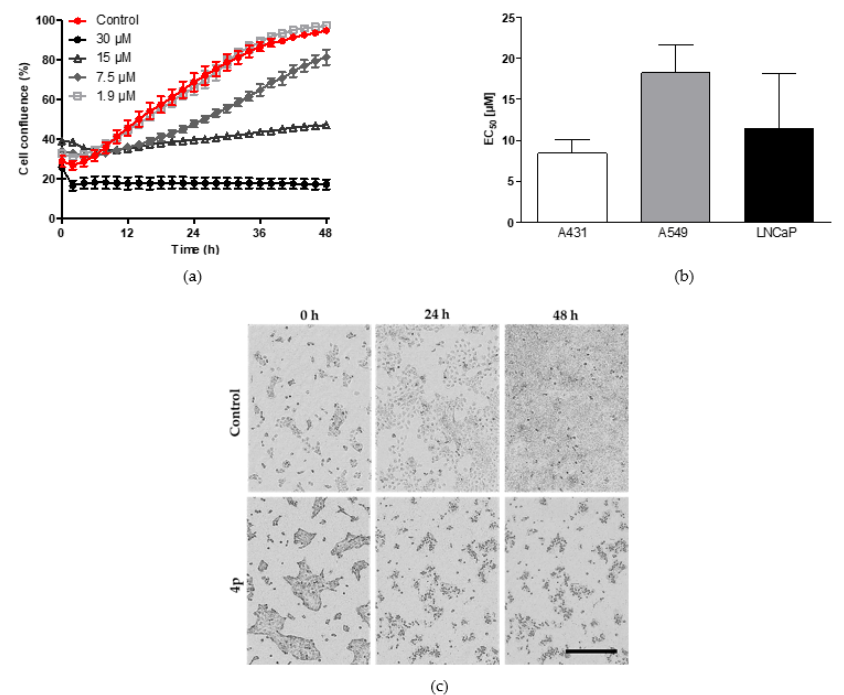
Figure 3. Investigation of the antiproliferative effect of 4p in three different cancer cell lines. ( a ) Representative time-course of the percent confluence changes of A431 cells following treatment with 4p at four different concentrations (1.9–30 µM) or vehicle (1% DMSO) for 48 h. ( b ) EC 50 values of 4p in A431, A549, and LNCaP cells. Data represent mean ± SD values from three independent experiments, each in triplicate. ( c ) Representative phase contrast images of A431 cells treated with 30 µM of 4p or vehicle (1% DMSO control). Images were taken at three different time points: directly after treatment (0 h), at 24 h, and 48 h following treatment. Scale bar (400 µM) for all images is shown in black.